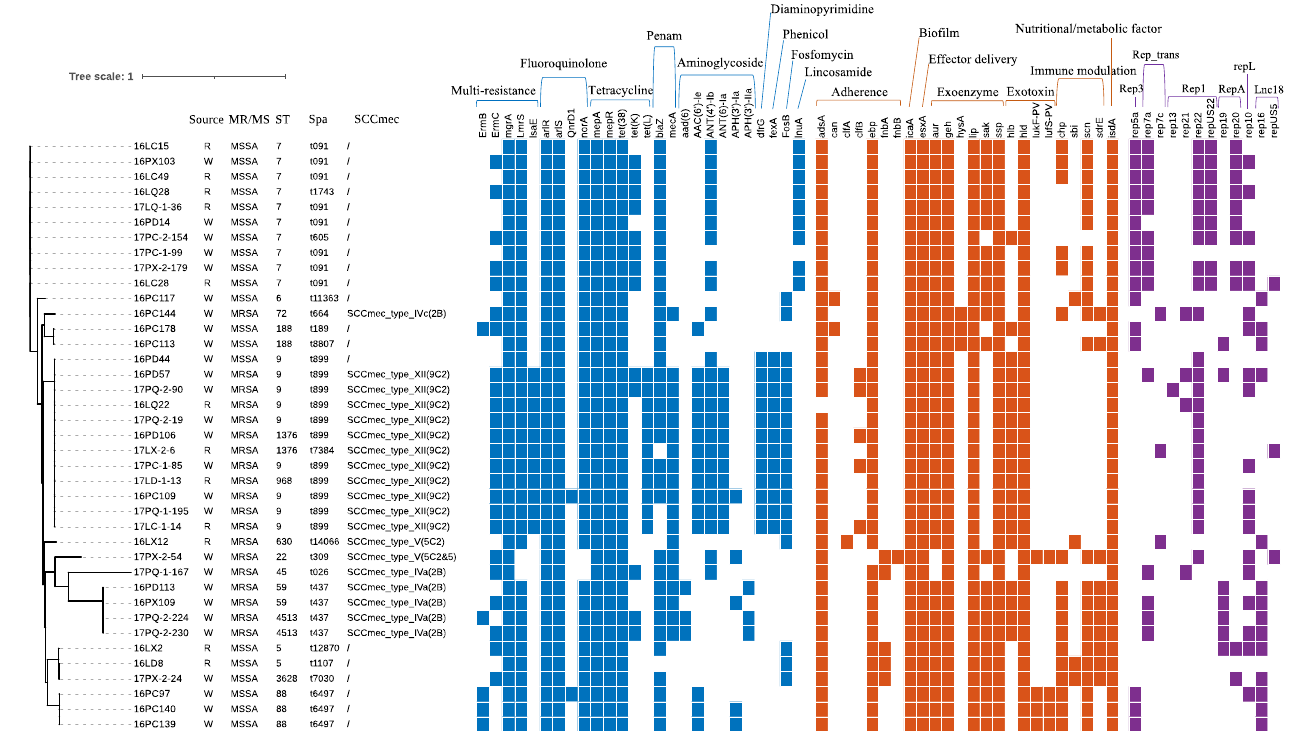
Figure 3. Core SNP tree of the 39 S. aureus isolates from wholesale and retail pork in Wuhan, China. All isolates came from wholesale markets (W) or retail markets (R). Different types of antimicrobial resistance genes, virulence genes, and plasmid replicators are displayed with the heat map (colored squares for positives), and the class of each gene is marked above the heat map (multiresistance: ErmB and ErmC: lincosamide, macrolide and streptogramin; mgrA: cephalosporin, fluoroquinolone, penam and peptide; tetracycline; LmrS: aminoglycoside, diaminopyrimidine, macrolide, oxazolidinone and phenicol; lsaE: lincosamide, macrolide, oxazolidinone, phenicol, pleuromutilin, streptogramin, and tetracycline). NCTC8325 was used as an S. aureus reference genome (NCBI genome: txid93061), and bootstrap values from 1000 replicates were performed but not shown on the branches.